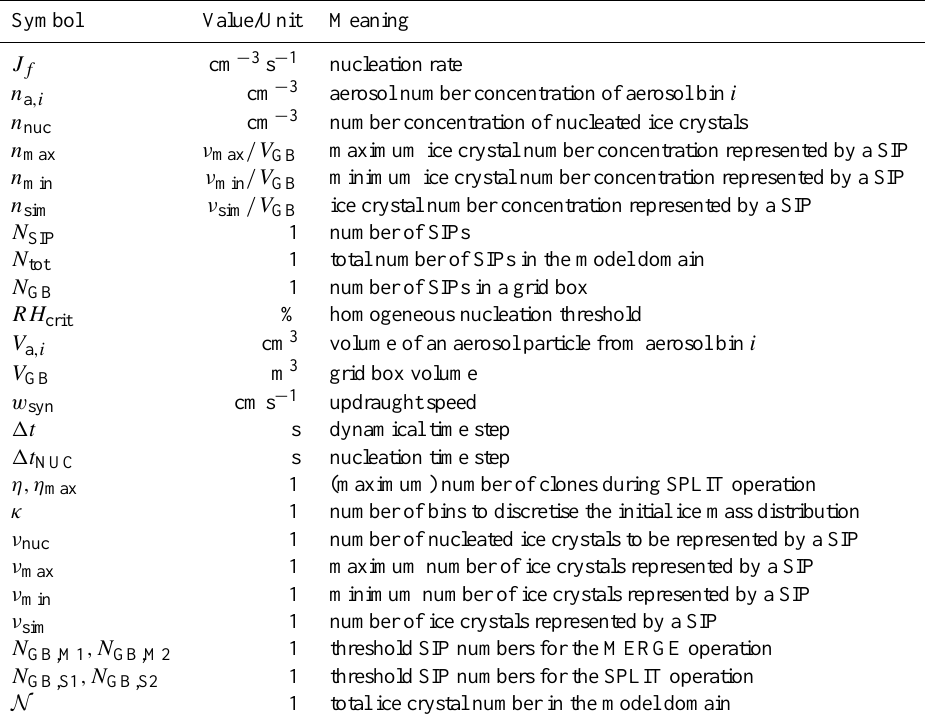
Table B1. List of